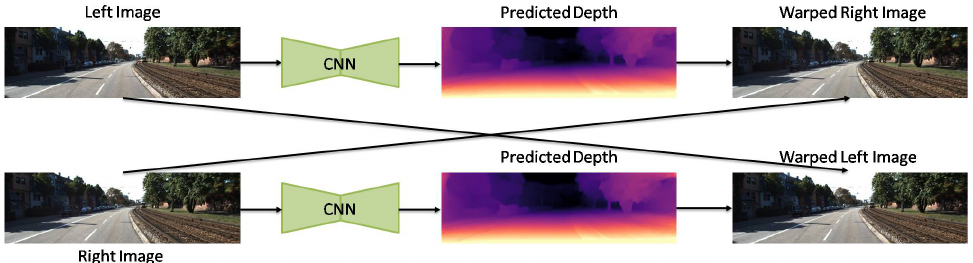
Figure 14. Components/inputs of the developed semi-supervised loss function by Kuznietsov et al.